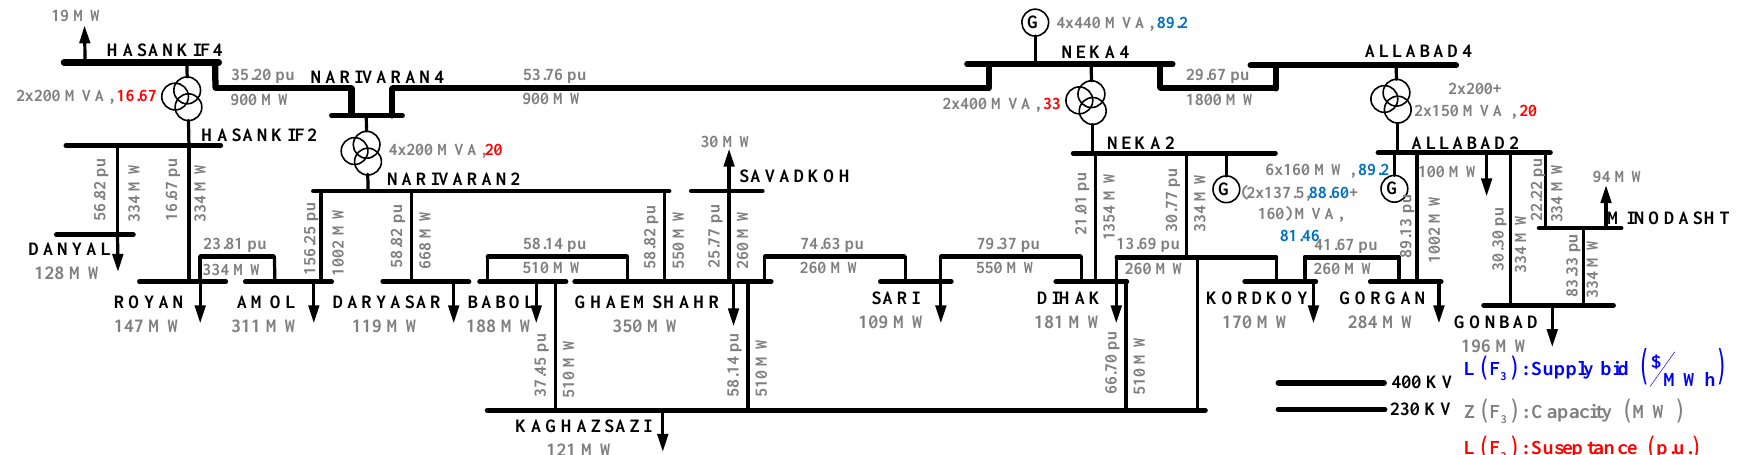
Figure 9. Single-line diagram of the MAZANDARAN Regional Electric Company (MREC) transmission